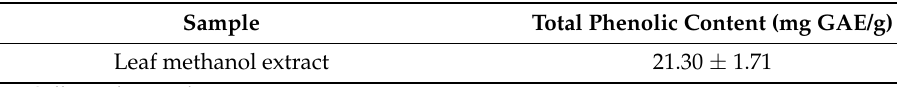
Table 2. Total phenolic content of C. hastata . Sample Leaf methanol extract